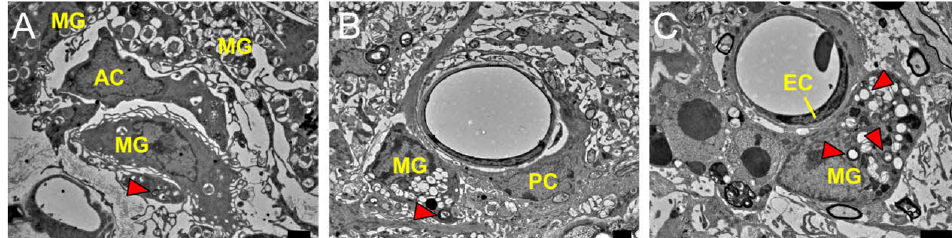
Figure 3. Electron microscopy at 14 days poststroke showed that MGs, which phagocytosed debris including damaged myelin (arrowhead), interacted with ACs ( A ), PCs ( B ), or ECs ( C ) in pathological brains. Scale bars: 2 µm ( A – C ). Abbreviations: AC, astrocyte; EC, endothelial cell; MG, microglial cell; PC, pericyte.